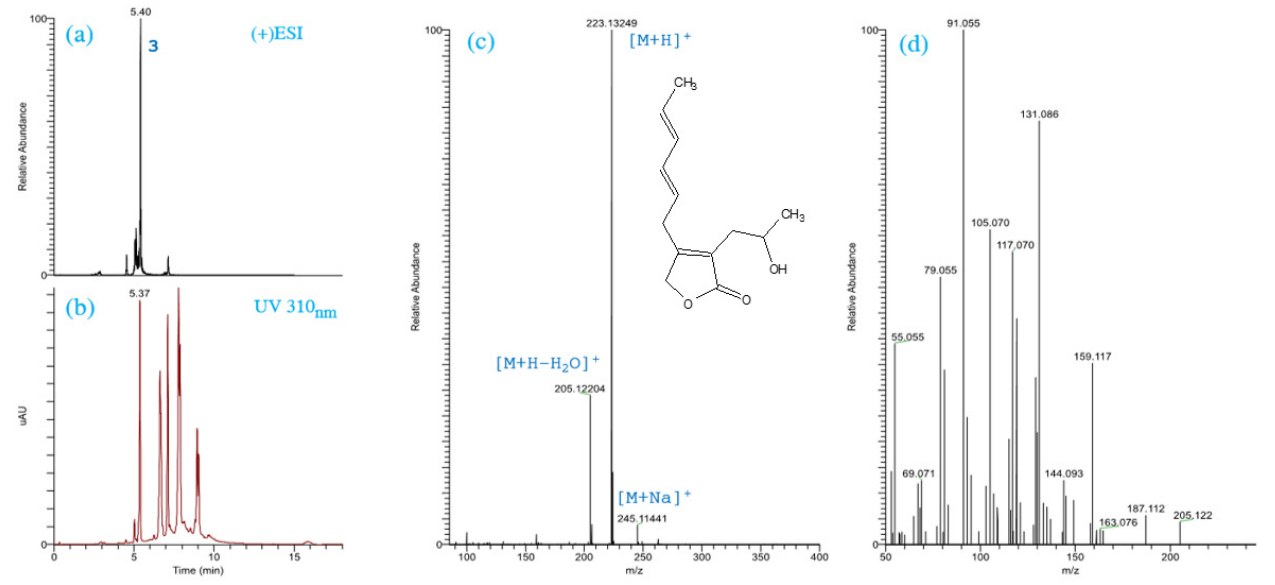
Figure 2. ESI(+)LC/MS (XIC, m / z 223.13249) trace, where 3 is peak No. ( a ), UV trace at 310 nm ( b ), ESI(+)LC/MS mass spectra and chemical structure of harzianolide ( c ), ESI(+)LC/MS/MS product-ion mass spectra of harzianolide ( m / z 223.13249; [M + H] + ) ( d ).